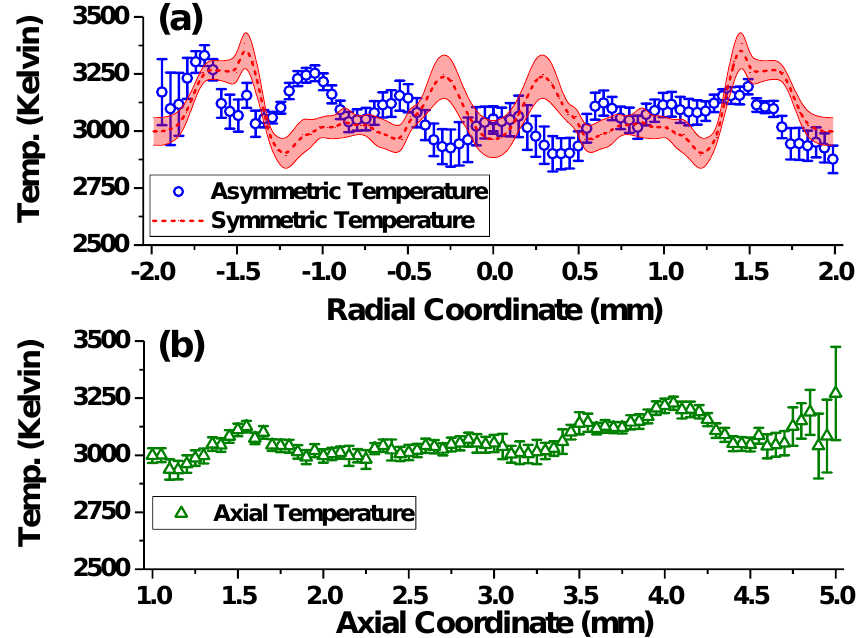
Figure 4. Temperatures inferred from AlO spectra at a time delay of 35 µ s following ablation ( a ) along the plasma radius using asymmetric and symmetric Abel inverted spectra and ( b ) along the plasma using spatially resolved line-of-sight spectral